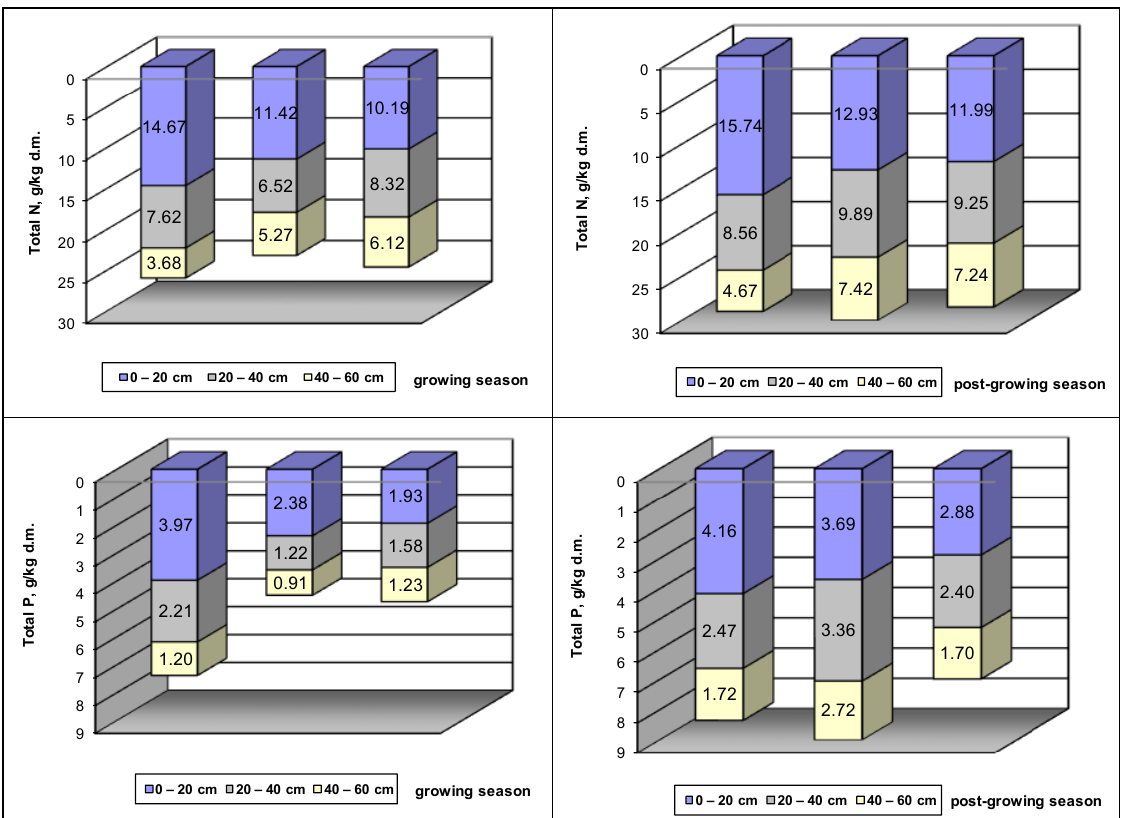
Figure 5. Seasonal concentration of TN and TP in the soil constructed wetland ( n = 10).